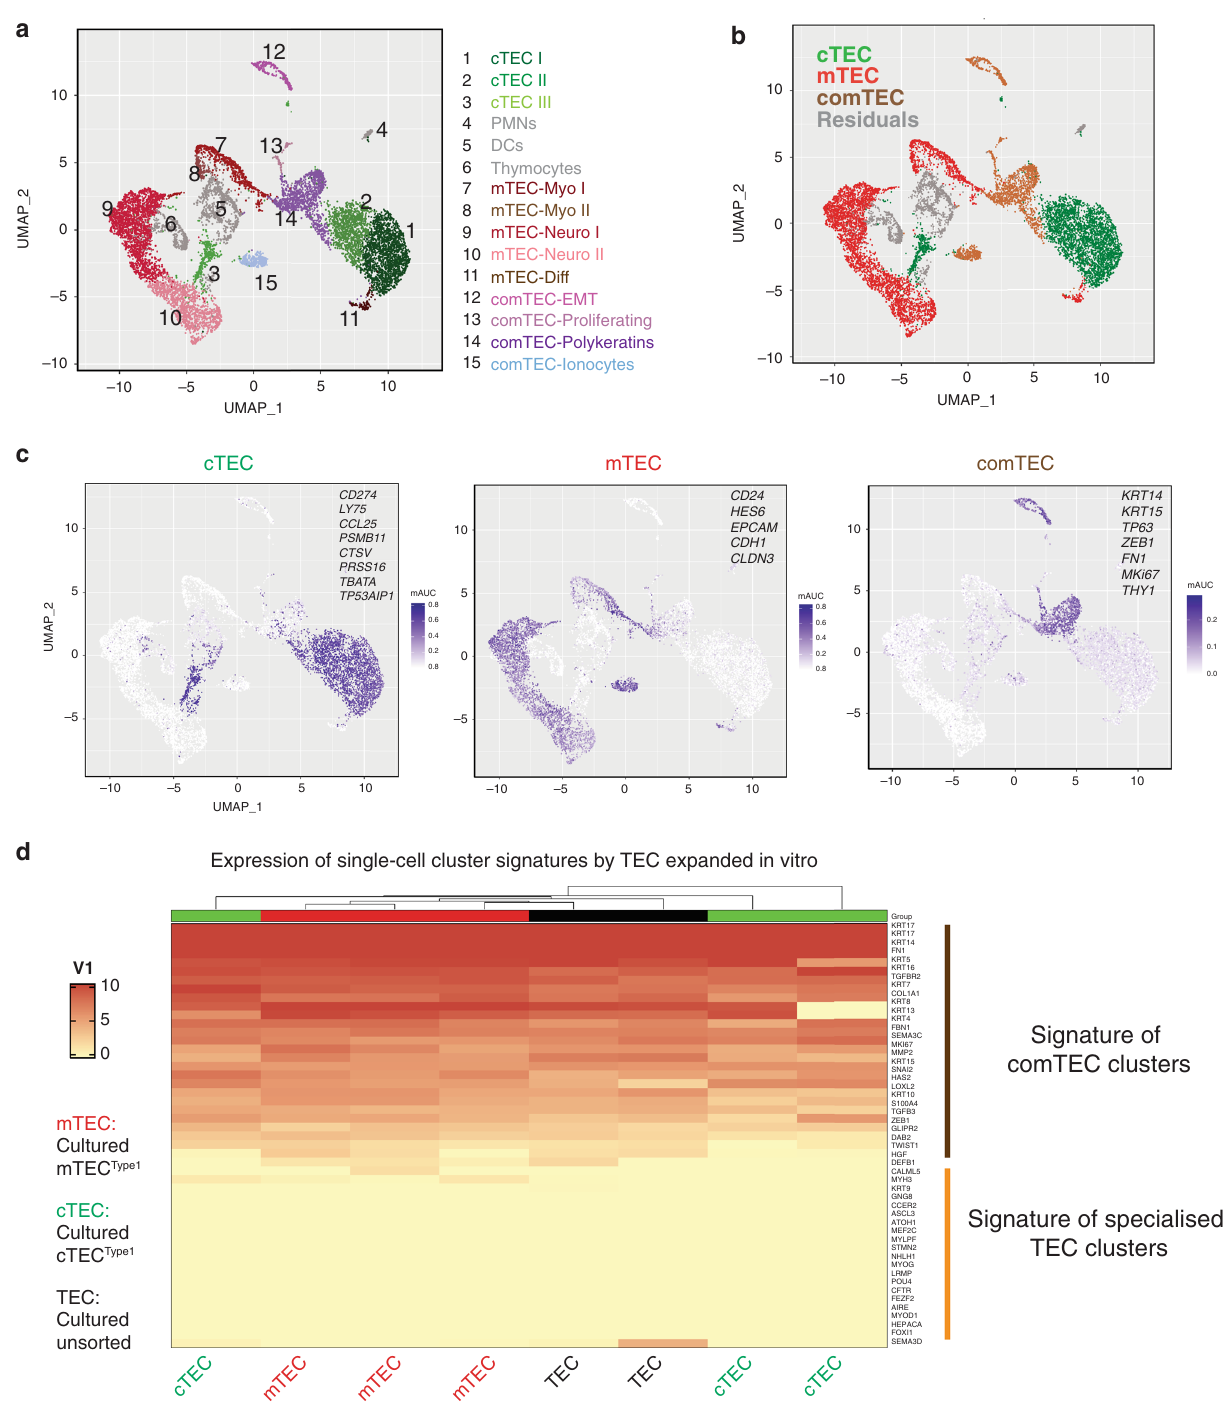
a non-destructive technique that permits visualisation of the vasculature containing blood (white, dense areas) via iodine contrast; moreover, it facilitated clear demarcation of cortical (brighter areas, C) and medullary regions (M) through virtual segmentation, thereby demonstrating whole-organ 3D imaging of the thymus at high resolution (Fig. 4b; Supplementary Fig. 4a and Supplementary Movie 2). When the parenchyma was rendered more transparent, the 3D whole-organ micro-CT images allowed enhancement of the 3D thymic vascularisation segmented in red (Fig. 4c). Standard histology by masson trichrome (MT) and haematoxylin & eosin (H&E) stains